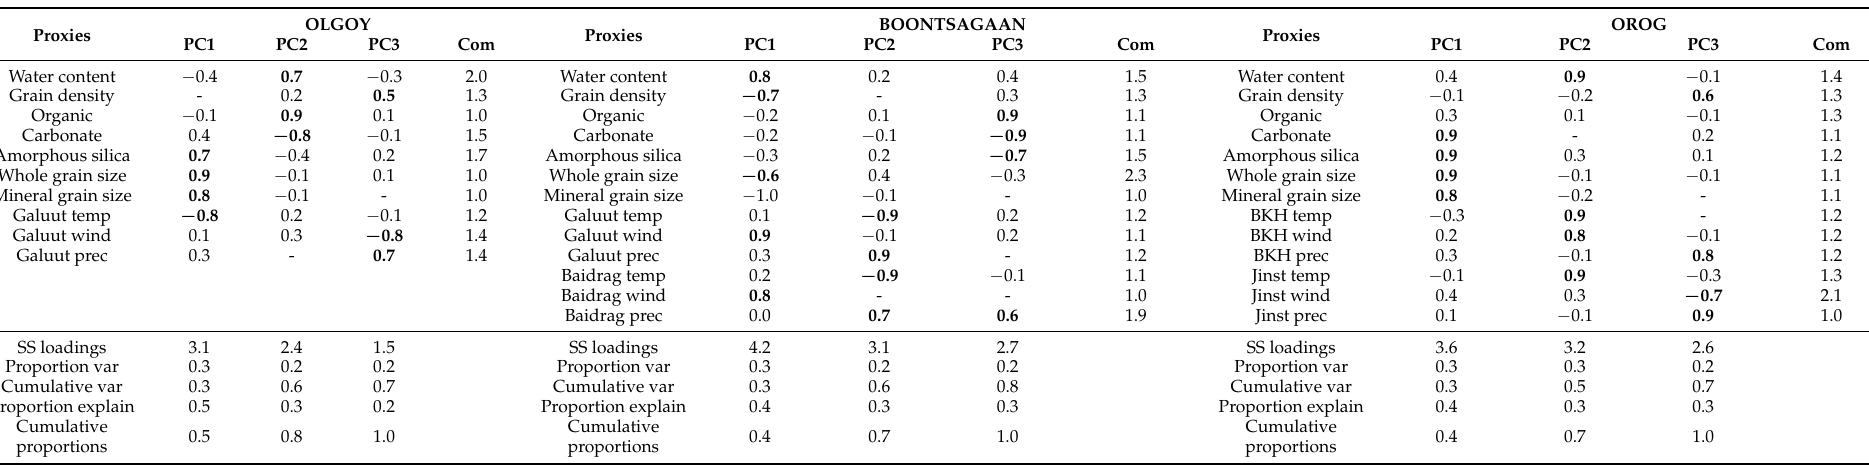
Table 3. PCA of meteorological data and sediment characteristics for Olgoy Boontsagaan and Orog lakes (highest ( ≥ 0.5). Coefficients for climatic factors are marked in bold, and temp stands for temperature, prec stands for precipitation, and var stands for